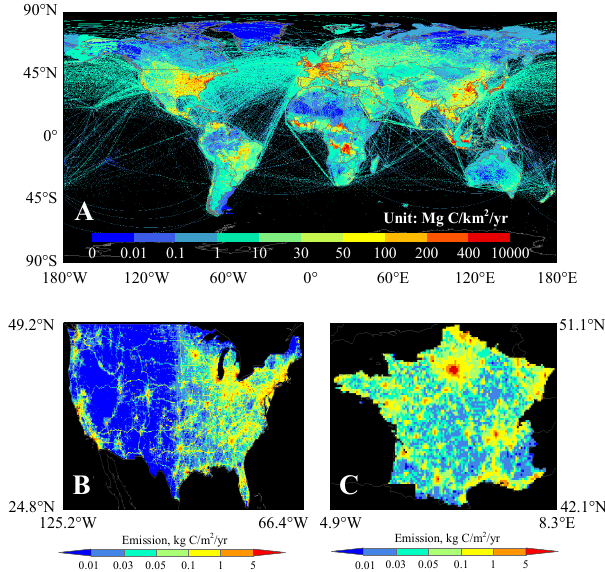
Figure 2. Fossil fuel emission maps obtained from current invento- ries. (A) Annual emission map for the year of 2010 from EDGAR (release version-4.2 FT2010). The resolution is 10km. (B) Fossil fuel emission map of the US for the year of 2002 with temporal variability obtained from air pollution data, traffic, and other indus- trial activity data from the VULCAN project (version 2.2). The res- olution is the one of each activity. (C) Map of fossil fuel emissions for the year of 2007 at 10km – hourly for France, obtained by dis- aggregation of national emission statistics using activity data and emission factors for each source of emission from IER, Stuttgart (the IER product has a European coverage). The same color scale is applied for (B) and (C)